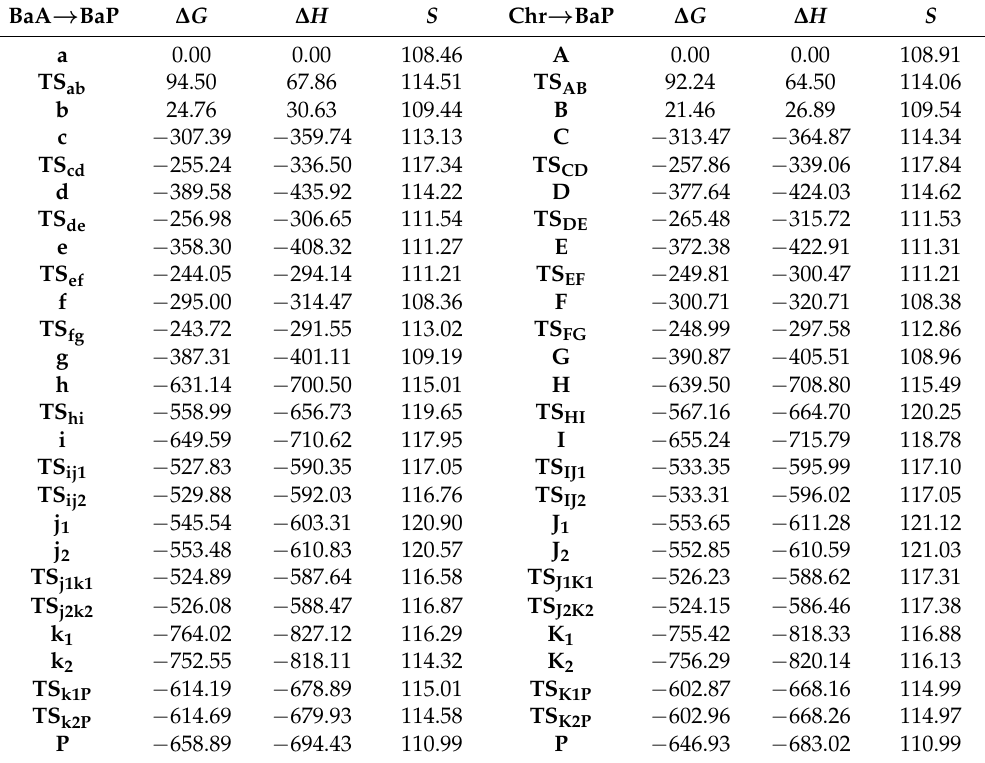
Table 1. Relative Gibbs free energy ( ∆ G, kJ/mol ), relative enthalpy ( ∆ H, kJ/mol), and enthropy ( S , cal/mol*K) values of benzo(a)pyrene (BaP) formation mechanism starting from chrysene (Chr → BaP) or benzo(a)anthracene (BaA → BaP) computed at the M06-2X/6-311++G(d,p) level of theory using a fine-tuned integration grid (99 radial shells and 974 angular points per shell), at 298.15 K and 1 atm within the harmonic oscillator rigid rotor